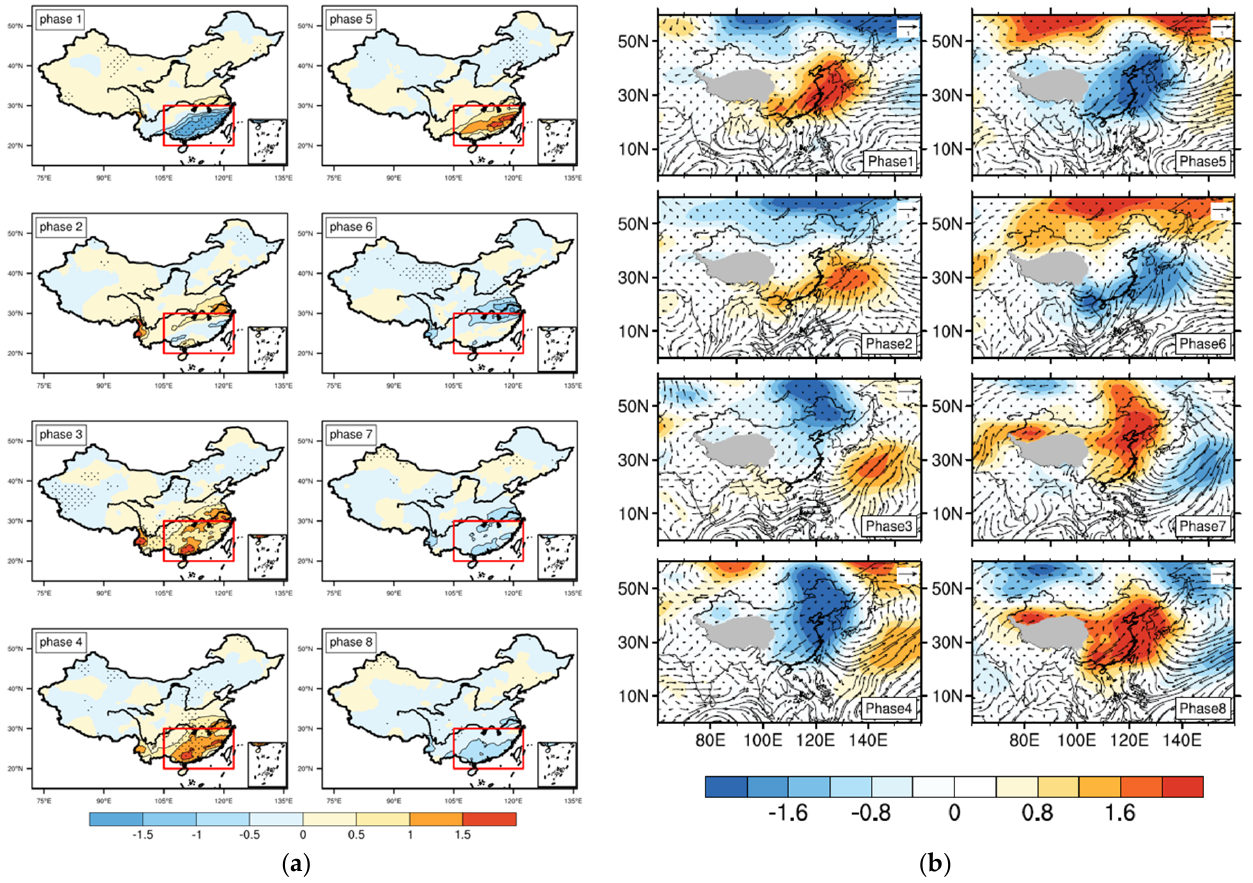
Figure 6. The 10–30-d filtered ( a ) precipitation field (units: mm/day) and ( b ) 850-hPa temperature field (shading, unit: °C) and water vapor flux (vector, unit: g·cm − 1 ·hPa − 1 ·s − 1 ) phase synthesis. (Dotted areas are where precipitation passed 95% significance test; grey area indicates the Tibetan Plateau.)